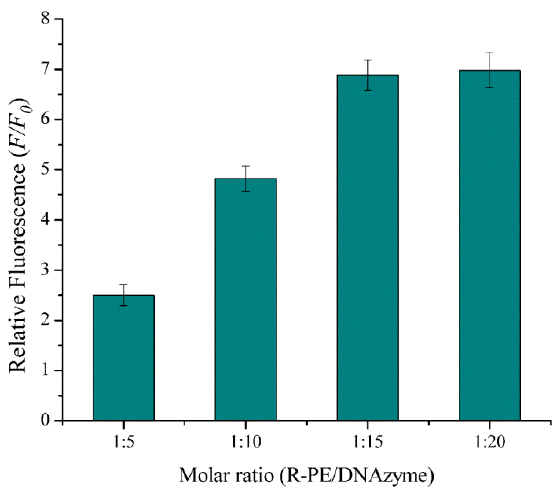
Figure 3. Relative fluorescence intensity of the DNAzymes-R-PE at a different R-PE-to-complex molar ratio. F 0 ( F ) was the fluorescence intensity of DNAzyme-R-PE before (after) the addition of 150 nM Pb 2 +